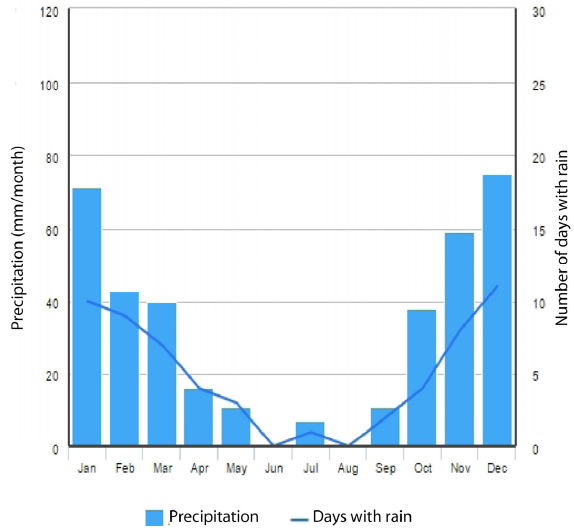
Figure 2. Annual distribution of rainfall for Santorini [13].